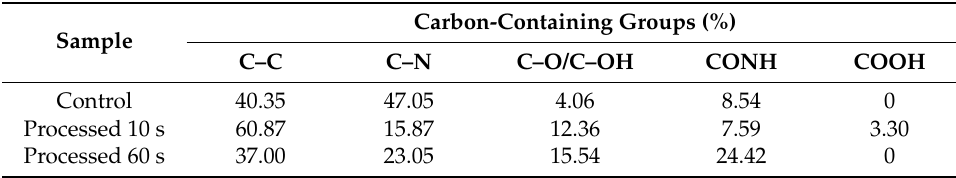
Table 2. Corresponding contents of various carbon-containing groups (%).